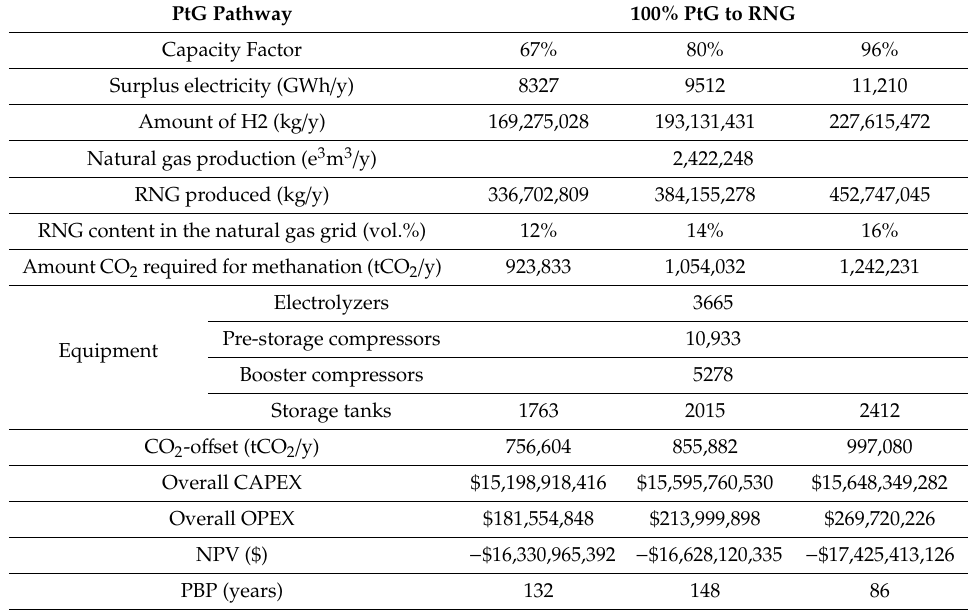
Table 11. Hydrogen allocation, Scenario